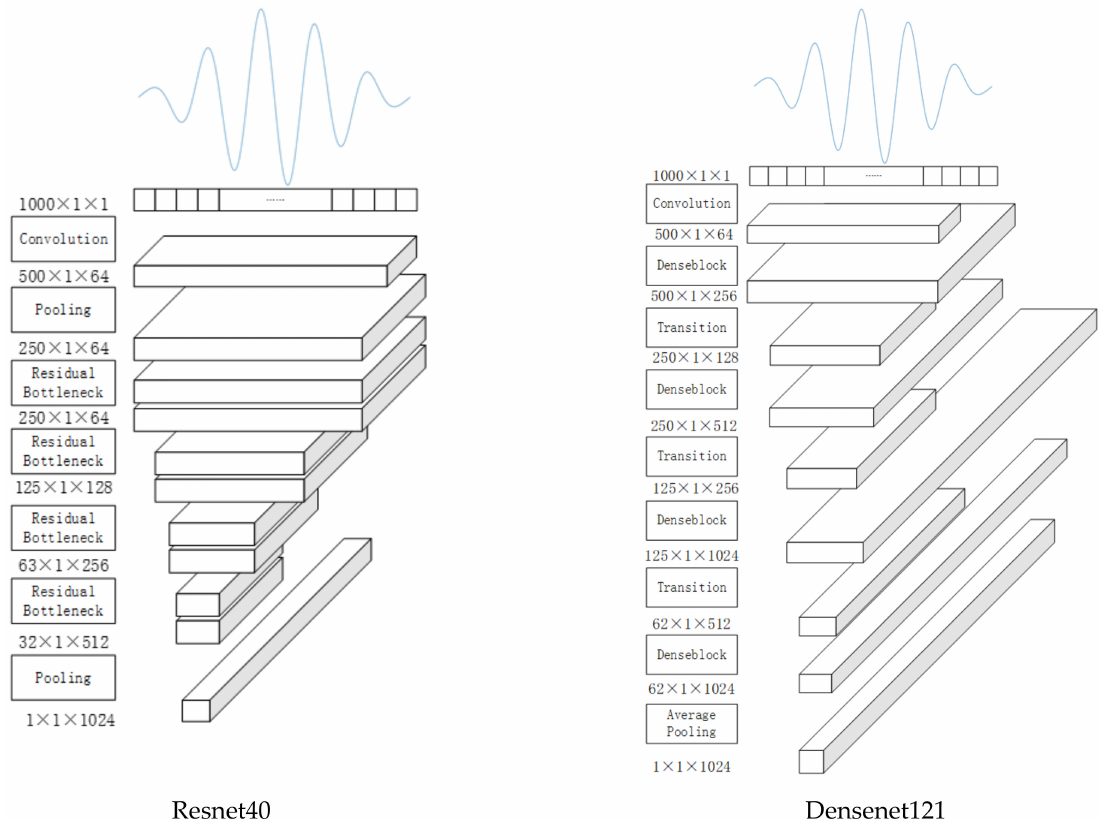
Figure 4. Structures of Resnet40 and